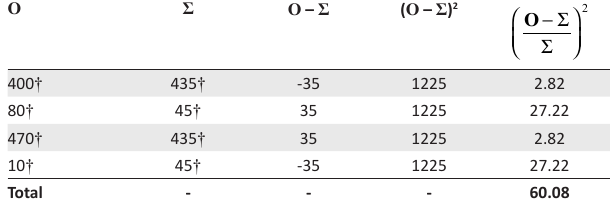
TABLE 5: Computation of Chi-square table.